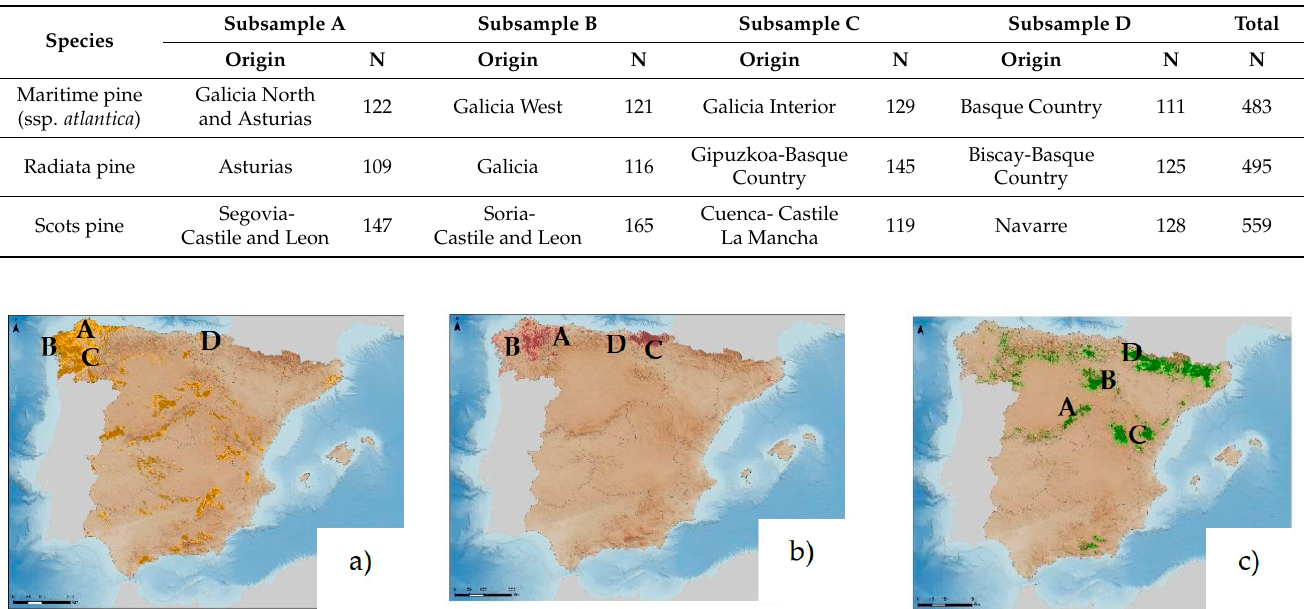
Figure 3 . Identification of subsamples by species: ( a ) maritime pine; ( b ) radiata pine; and ( c ) Scots pine.